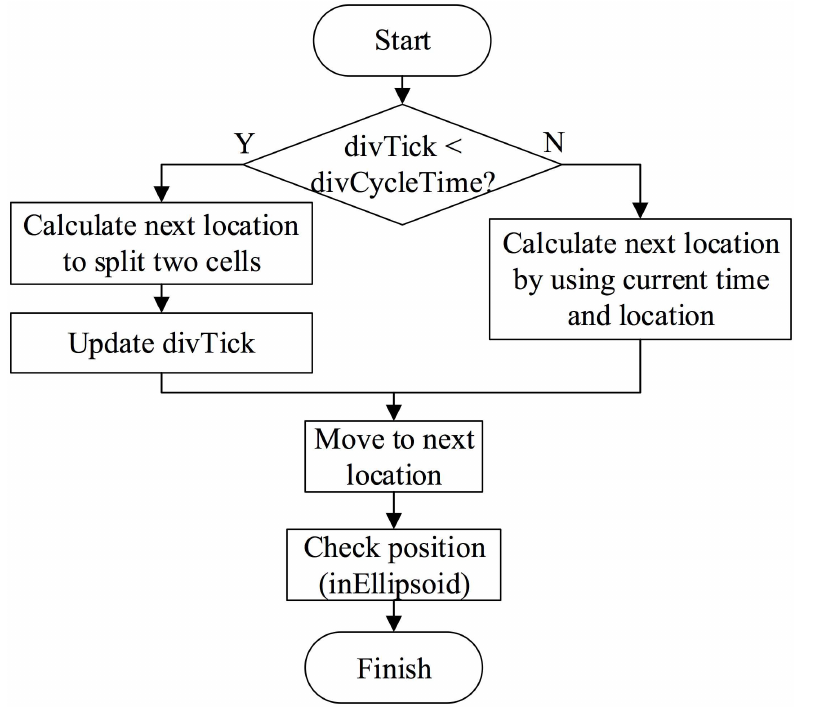
Fig 2. Movement activity of the